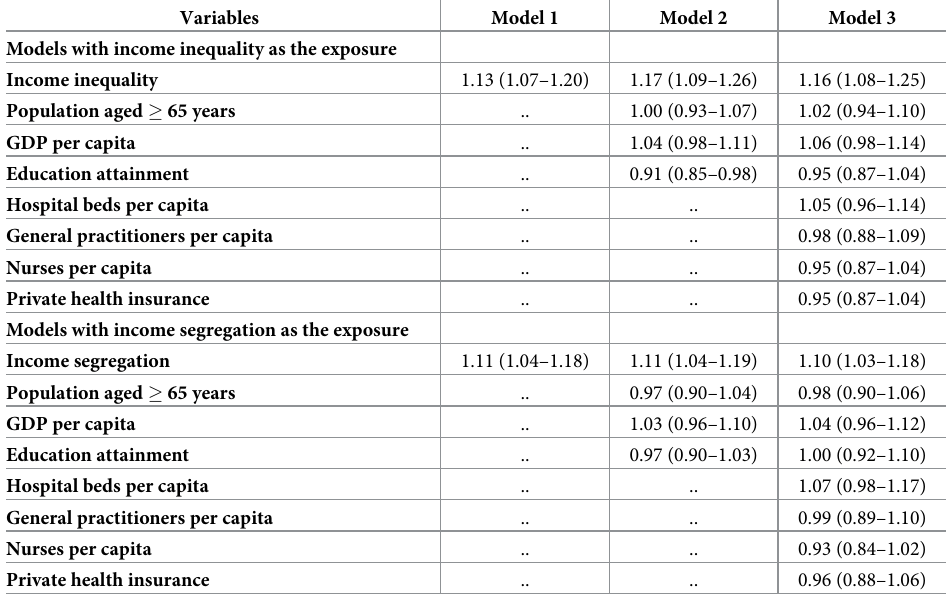
Table 3. Estimated associations (rate ratios and 95% confidence intervals) between city weekly COVID–19 mor- tality rates and the exposures and adjustment factors using mixed negative binomial regression